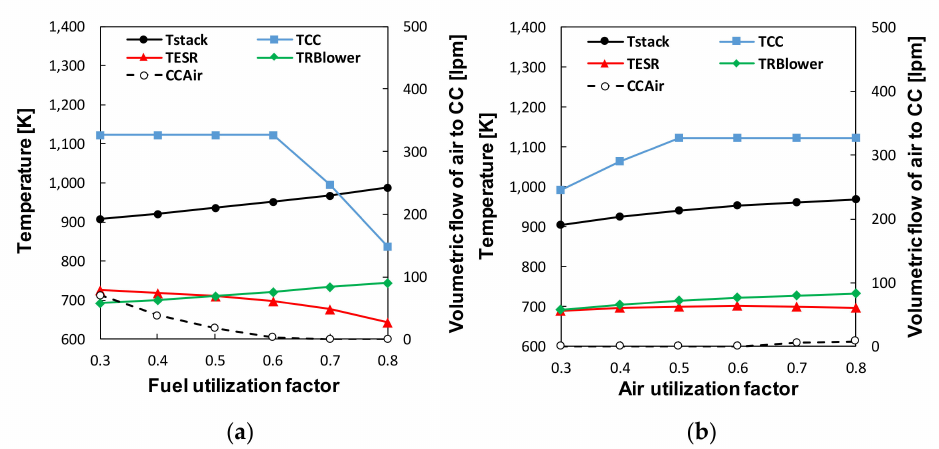
Figure 5. The effect of ( a ) fuel and ( b ) air utilization factors on the AOGR #1 system.4.3.3. SOFC System with AOGR